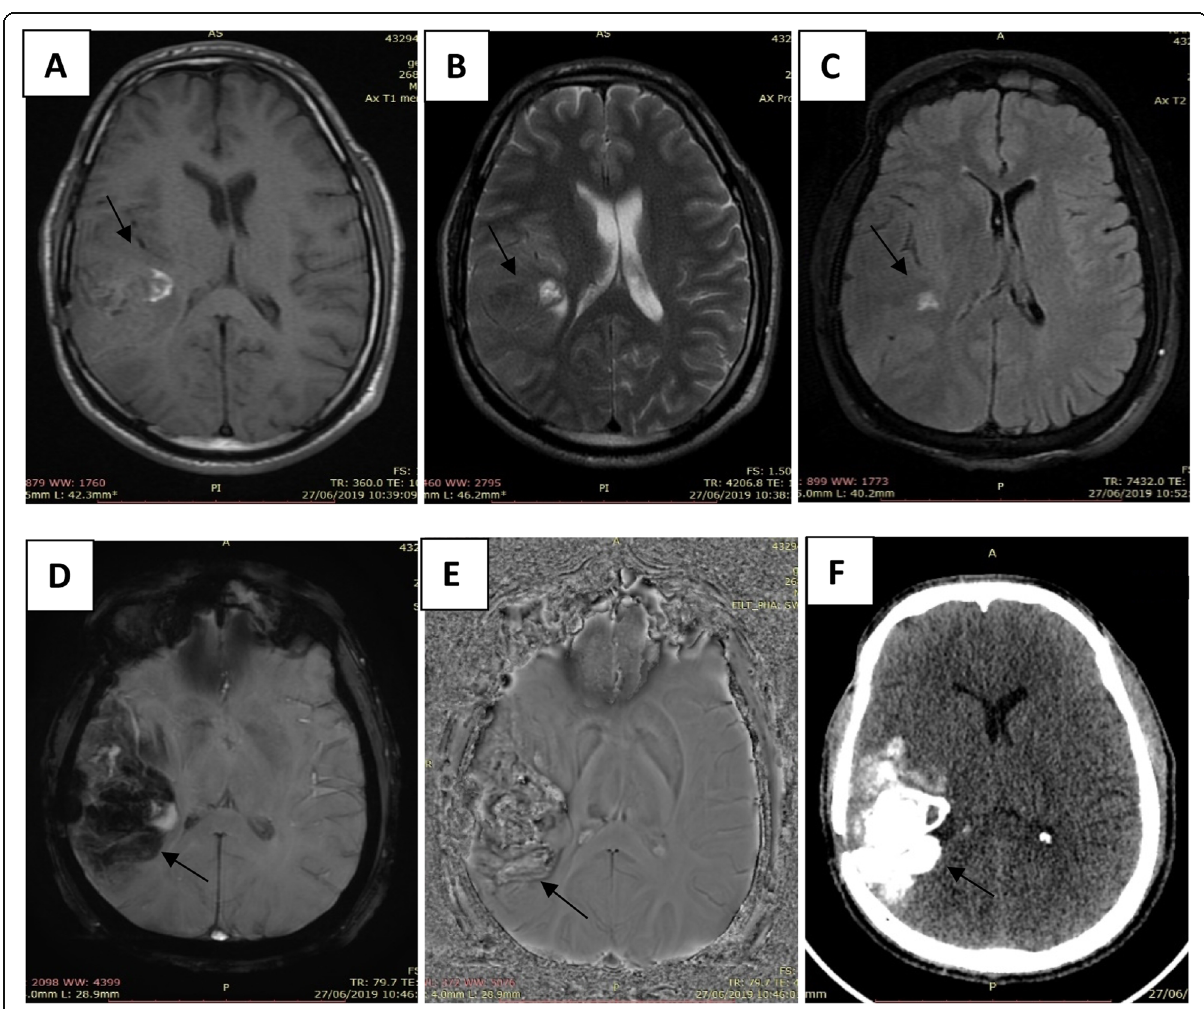
Fig. 2 Male patient aged 39 years old, presented with repeated headache and drowsiness with past history of oligodendroglioma that was surgically removed. Current MRI showed right tempro-parietal space occupying lesion with non-specific signal intensity in T1WI, T2WI, and FLAIR sequences ( a , b, and c ) showing large intervening low signal intensity in SWI ( d ), high signal intensity in filter phase ( e ), and corresponding large hyperdense area in CT ( f ) denoting calcification mostly recurrent calcified